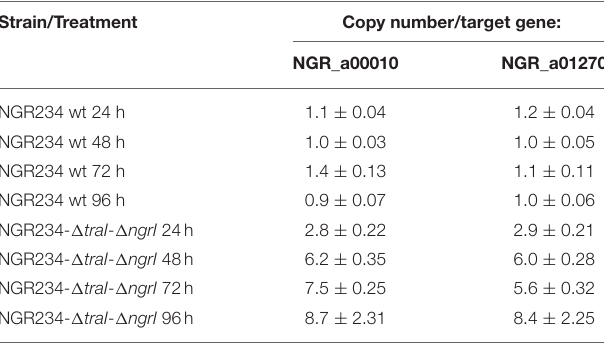
TABLE 1 | Copy number of pNGR234 a estimated using qPCR and primers for the ORFs NGR234_a00010 and NGR234_a01270. Strain/Treatment Copy number/target gene: